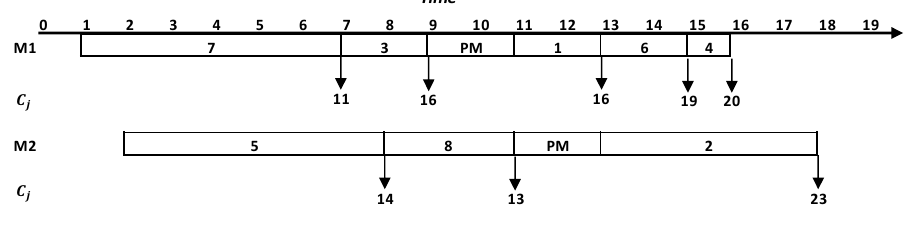
Figure 1. Gantt chart of the example ( C max = 23 ).